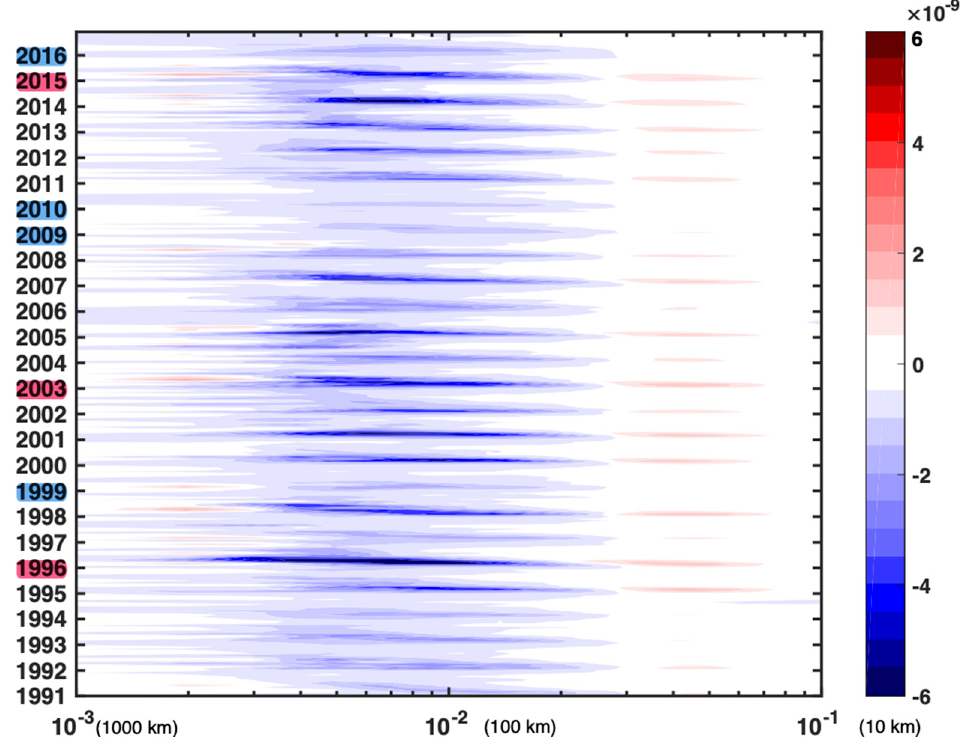
Figure 9. Time series of surface spectral KE flux ( Π in Equation (3), 1×10 − 9 m 2 s − 3 ) in the STCC region from 1991 to 2016. The submesoscale KE (KE_SM) is large (small) in the years with red (blue) shading in the vertical axis. Horizontal axis indicates wavenumber (cycle km − 1 ). 10 − 3 cycle km − 1 , 10 − 2 cycle km − 1 , and 10 − 1 cycle km − 1 correspond to the scales of 1000 km, 100 km, and 10 km,